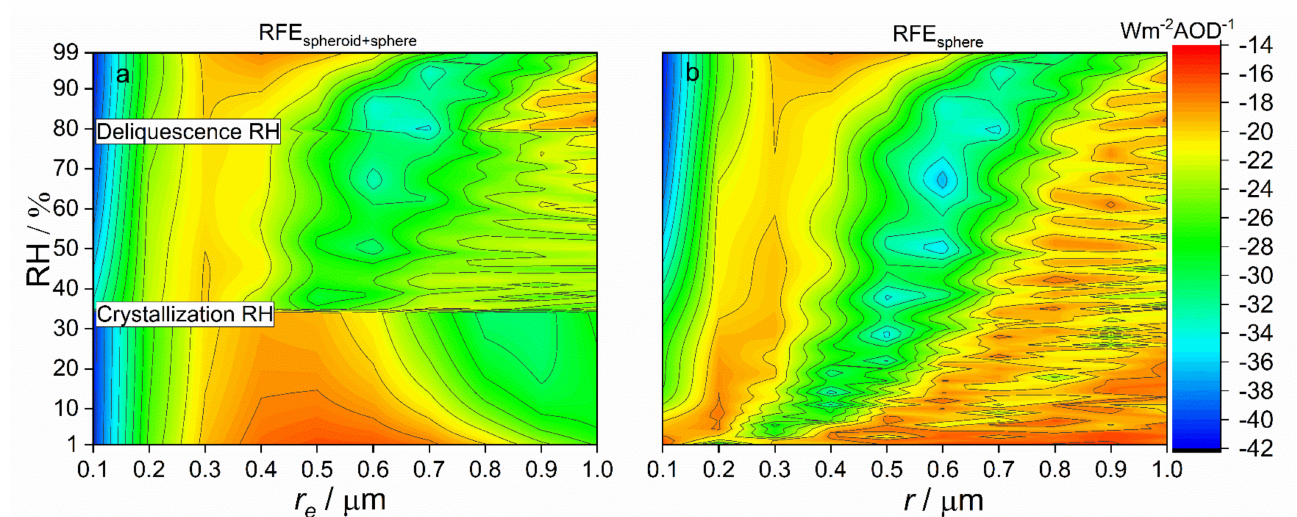
Figure 4. The RFE estimated for ( a ) non-spherical and spherical (NH 4 ) 2 SO 4 particles and ( b ) only spherical (NH 4 ) 2 SO 4 particles.